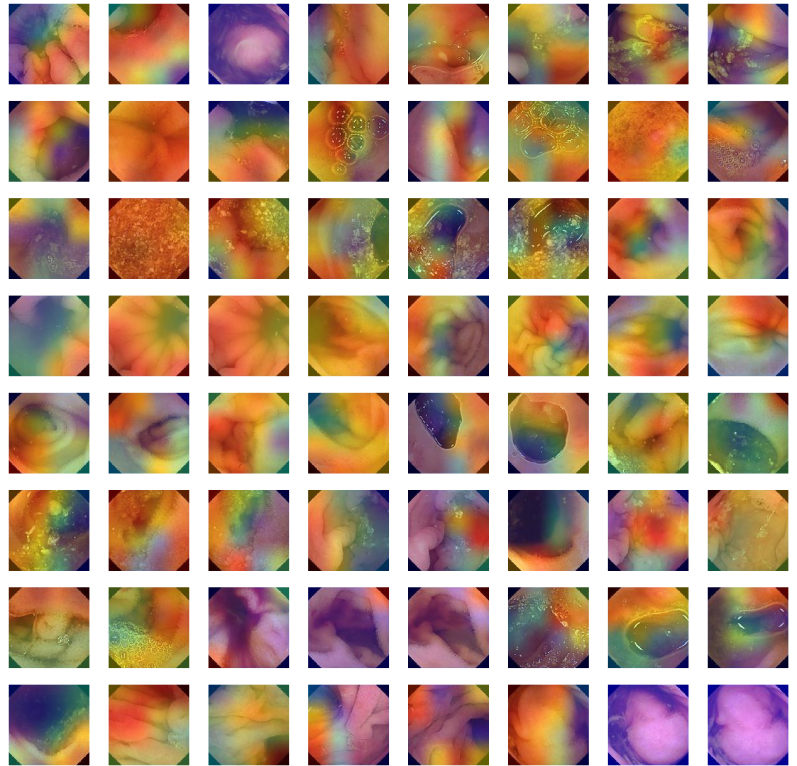
Figure 16. Grad-CAM visualization of GI tract